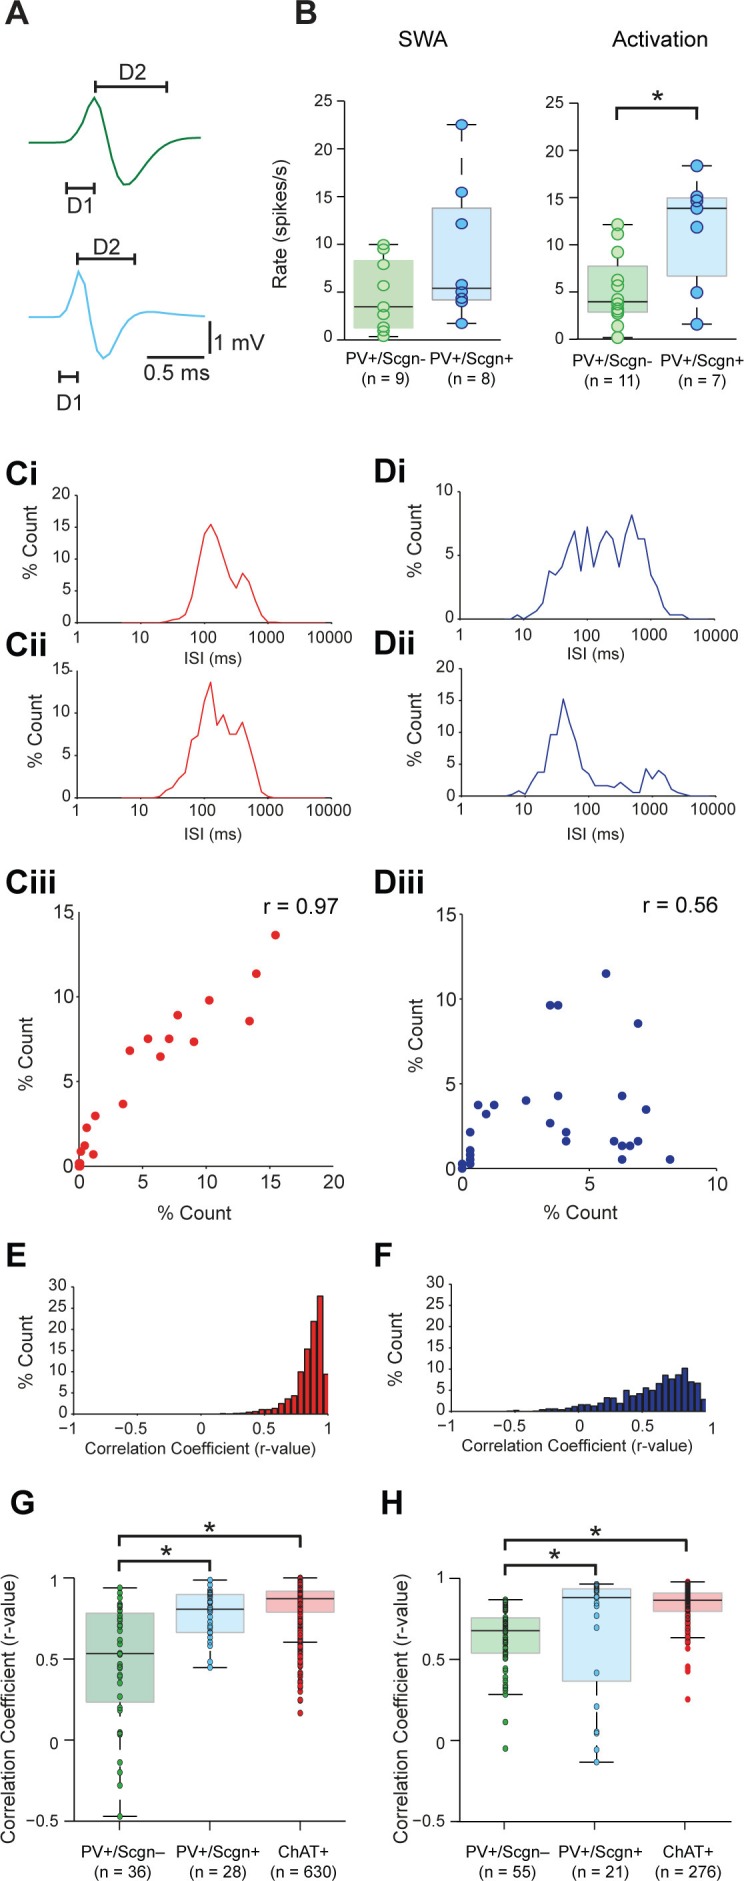
Identified PV+/Scgn- and PV+/Scgn+ interneurons in the dorsal striatum of rats have distinct electrophysiological properties.(A) The mean action potential waveforms of PV+/Scgn-(green) and PV+/Scgn+(blue) interneurons. Both groups had short waveforms (around 1 ms). Waveforms were split in to D1 (baseline to its peak) and D2 (return to the baseline from peak). The D1 segment of PV+/Scgn+interneurons was significantly shorter than that of PV+/Scgn- interneurons. (B) The median firing rates of the two populations of PV+ interneuron were similar during SWA, but PV+/Scgn+ interneurons had a significantly higher firing rate than PV+/Scgn- interneurons during cortical activation. (C–F) The similarity of firing patterns between pairs of PV+/Scgn-, PV+/Scgn+ and cholinergic (ChAT+) interneurons was assessed by calculating the correlation coefficient (Spearman) between interspike interval (ISI) histograms. (Ci–ii) ISI histograms from the spike trains for two cholinergic interneurons recorded separately during cortical activation. (Ciii) Scatter plot of the % count in each ISI bin for the two ChAT+ interneurons plotted against each other. Because of the similar (unimodal) ISI distributions, the Spearman Rho correlation coefficient (r) for the pair of ChAT+ interneurons is relatively high. (Di–ii) As in C, but the analysis is now performed on two separately recorded PV+ interneurons. (Diii) Because of the more variable ISI distributions, the correlation coefficient (r) is relatively low. (E) Histogram of the correlation coefficients of 276 cholinergic interneuron pairs from recordings during cortical activation. The majority of correlations are high, indicating similar ISI histograms across the population. (F) Histogram of the correlation coefficients of 325 PV+ interneuron pairs from recordings during cortical activation. Correlations strengths are relatively spread; indicating ISI histograms are less similar than those of the cholinergic population. (G, H) Comparison of Spearman correlation coefficients of all PV+/Scgn-, PV+/Scgn+ and ChAT+ interneuron pairs recorded in SWA (G) and cortical activation (H). In both brain states, the correlation coefficients between pairs of PV+/Scgn+ ISI histograms was significantly higher than that of PV+/Scgn- pairs, but not significantly different to ChAT+ interneuron pairs.DOI:
http://dx.doi.org/10.7554/eLife.16088.01010.7554/eLife.16088.011Figure 5—source data 1.Source data for Figure 5A,B,G,H.